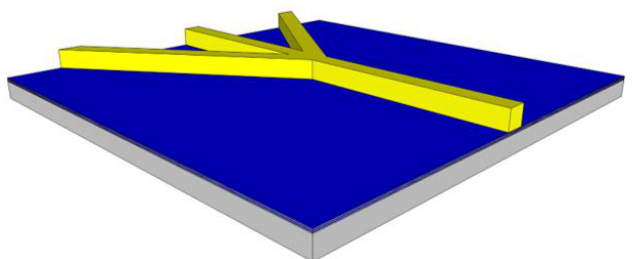
Figure 4. The modified 2DHF device requires a modified core step to allow two inlets on the side of the main sample channel. Subsequent fabrication steps require corresponding modifications to the photolithography patterns.